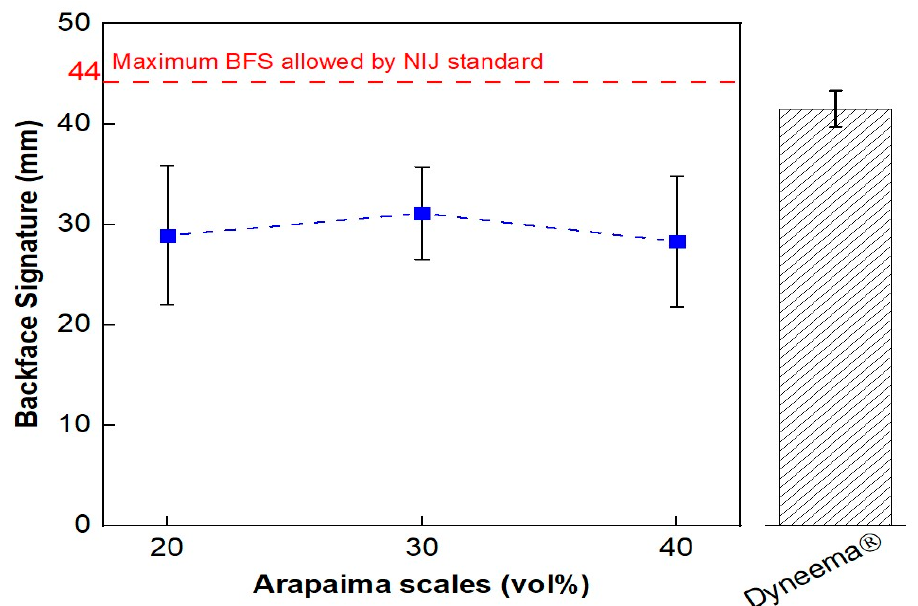
Figure 6. BFS measured for the multilayered armor systems with different volumetric fractions of arapaima scales: 20, 30, and 40 vol%, the maximum value allowed by NIJ standard and the values reported for Dyneema [34]. Table 10. ANOVA of the BFS depth from the ballistic tests of MAS with arapaima scales composites as second layer.